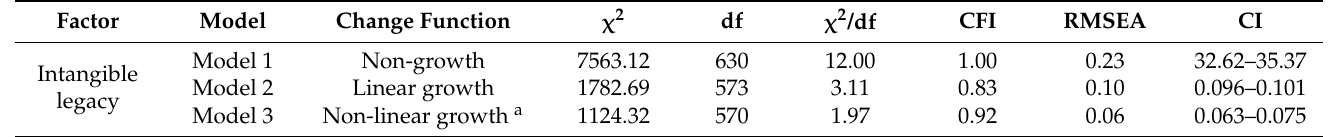
Table 3. Latent growth models: Alternative specifications.